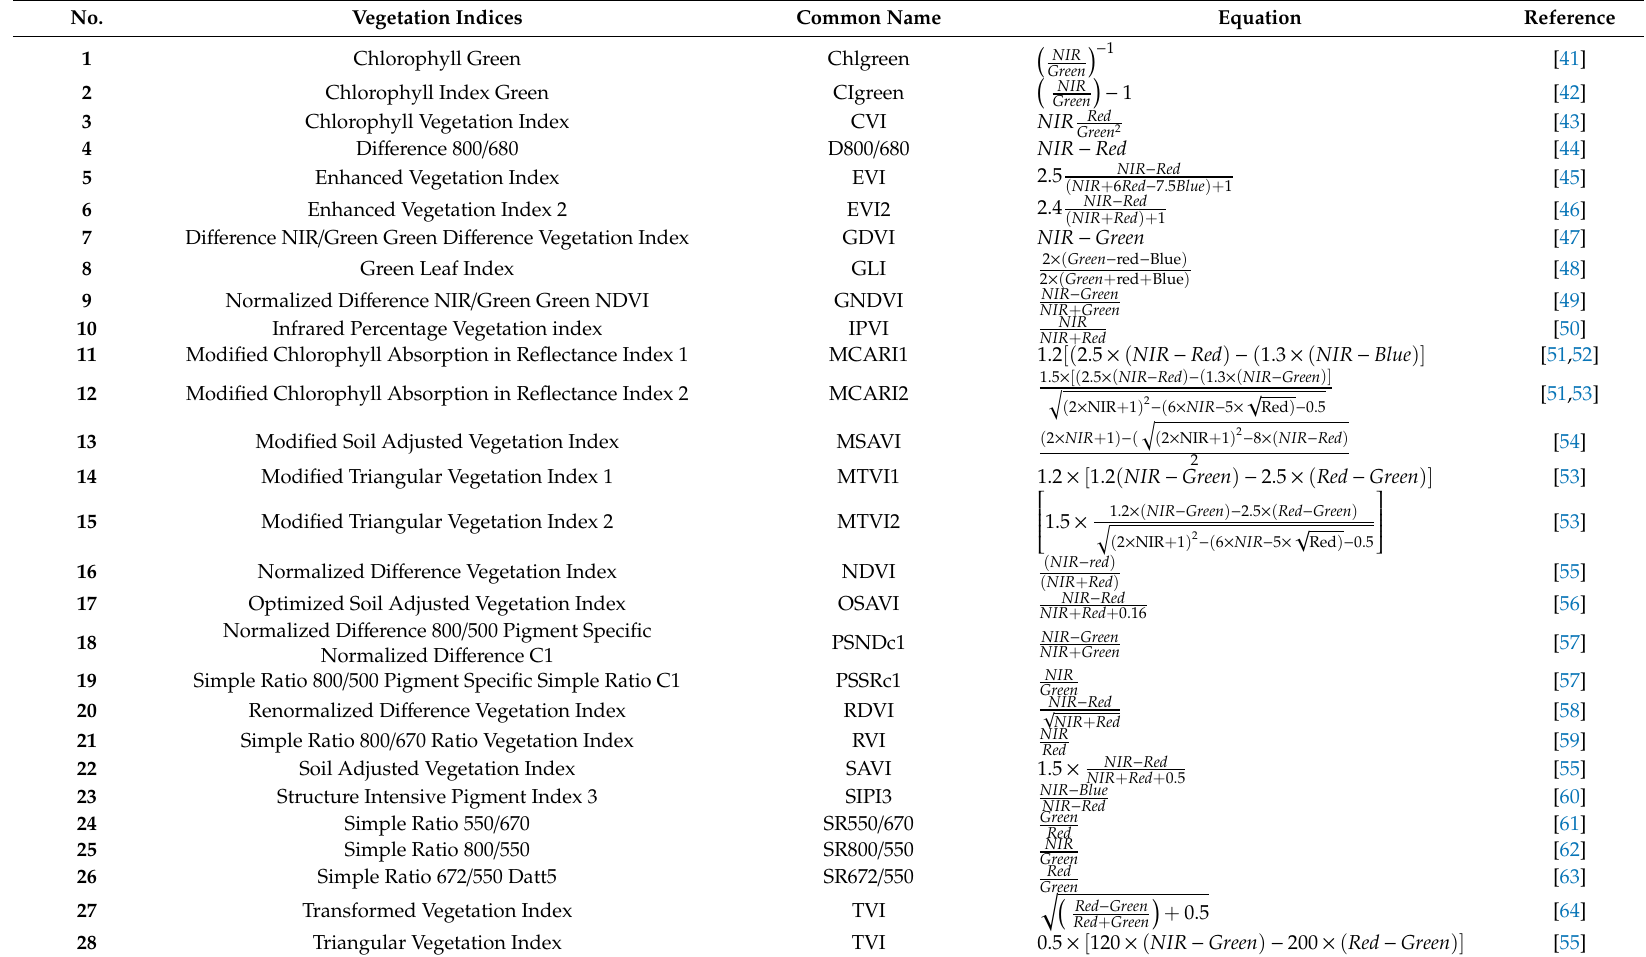
Table 5. Di ff erent vegetation